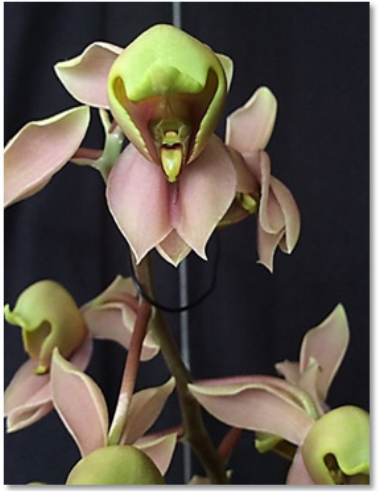
Figure 3. Catasetum albovirens Synonimy: Catasetum lamosii Rolfe [17]. (Source Luiz Otavio Adão)